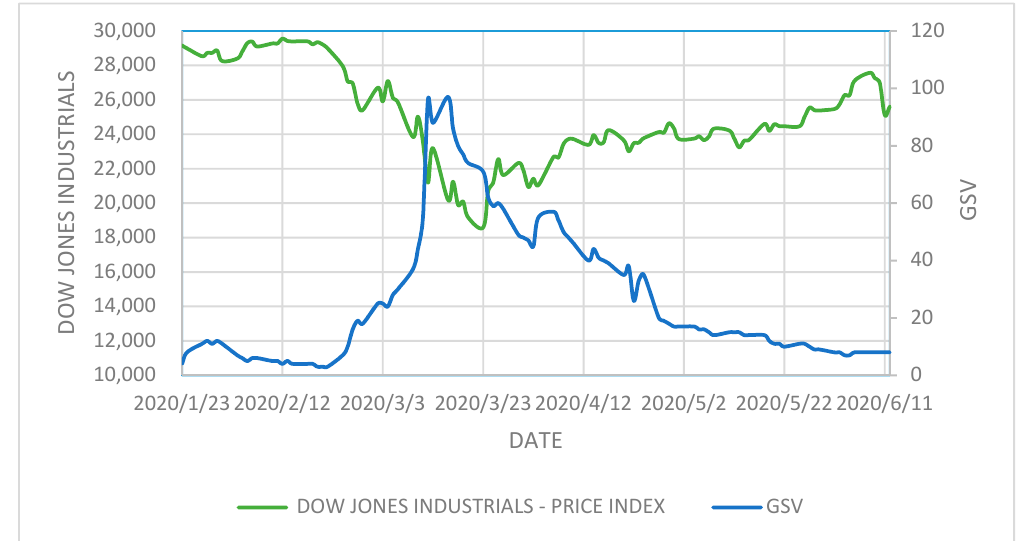
Figure 2. Movements of Google search volume (GSV) and the Dow Jones Industrial Index during the COVID-19 period. Sources: https://www.investing.com; https://trends.google.com/trends.